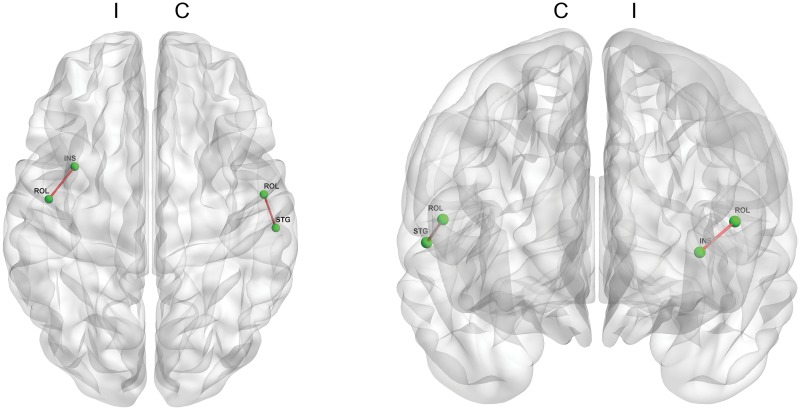
Functional connectivity correlated with the S&E ADL score.The functional connectivity between the Rolandic operculum and the insula in the ipsilateral hemisphere and between the Rolandic operculum and the superior temporal gyrus in the contralateral hemisphere are positively correlated with the S&E ADL score. (p<0.001) (Red line: a functional connectivity positively correlated with the S&E ADL score; C: contralateral hemisphere & I: ipsilateral hemisphere; S&E ADL: Schwab and England activities of daily living).